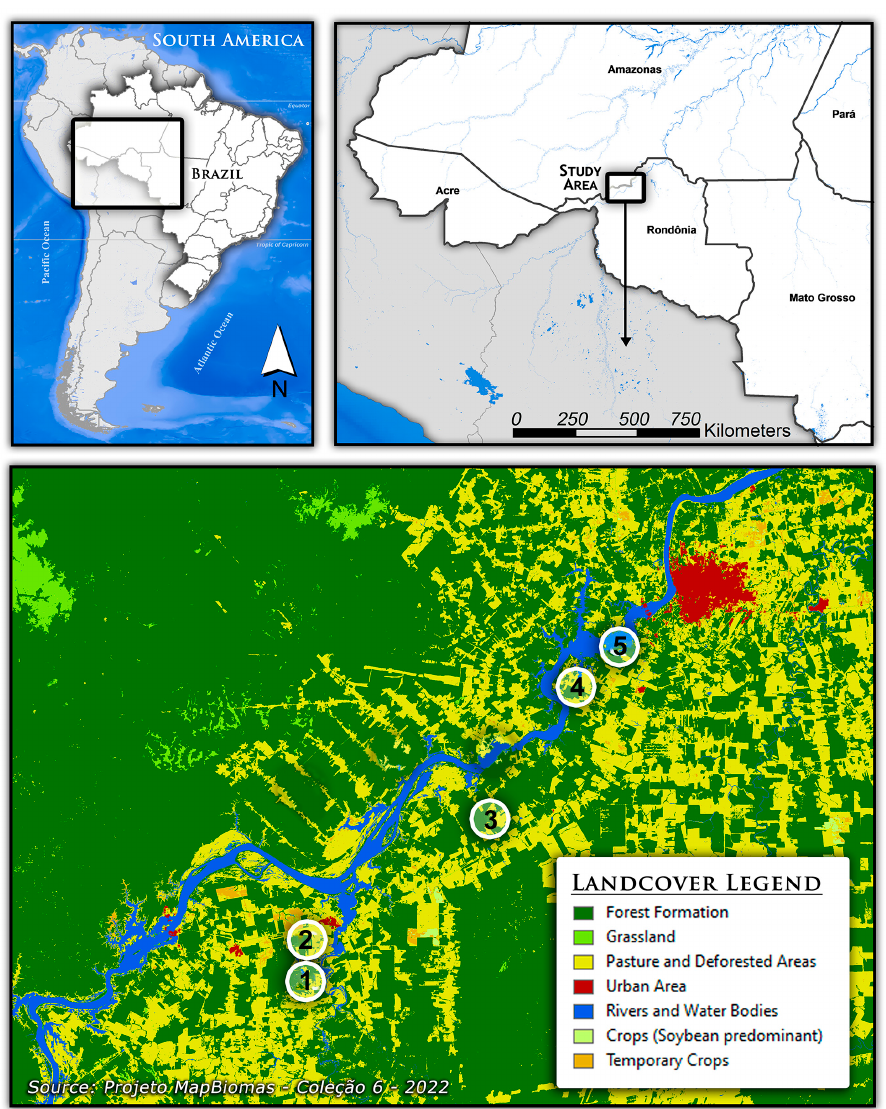
Figure 1. Specimen collections in five localities in the vicinities of the Porto Velho municipality, Rondônia state, Brazil. The numbers represent the collection sites: 1—Jaci Paraná River; 2—Sa- maúma, Jaci Paraná; 3—Santa Rita settlement; 4—Nova Teotônio village; 5—São Domingos settle-